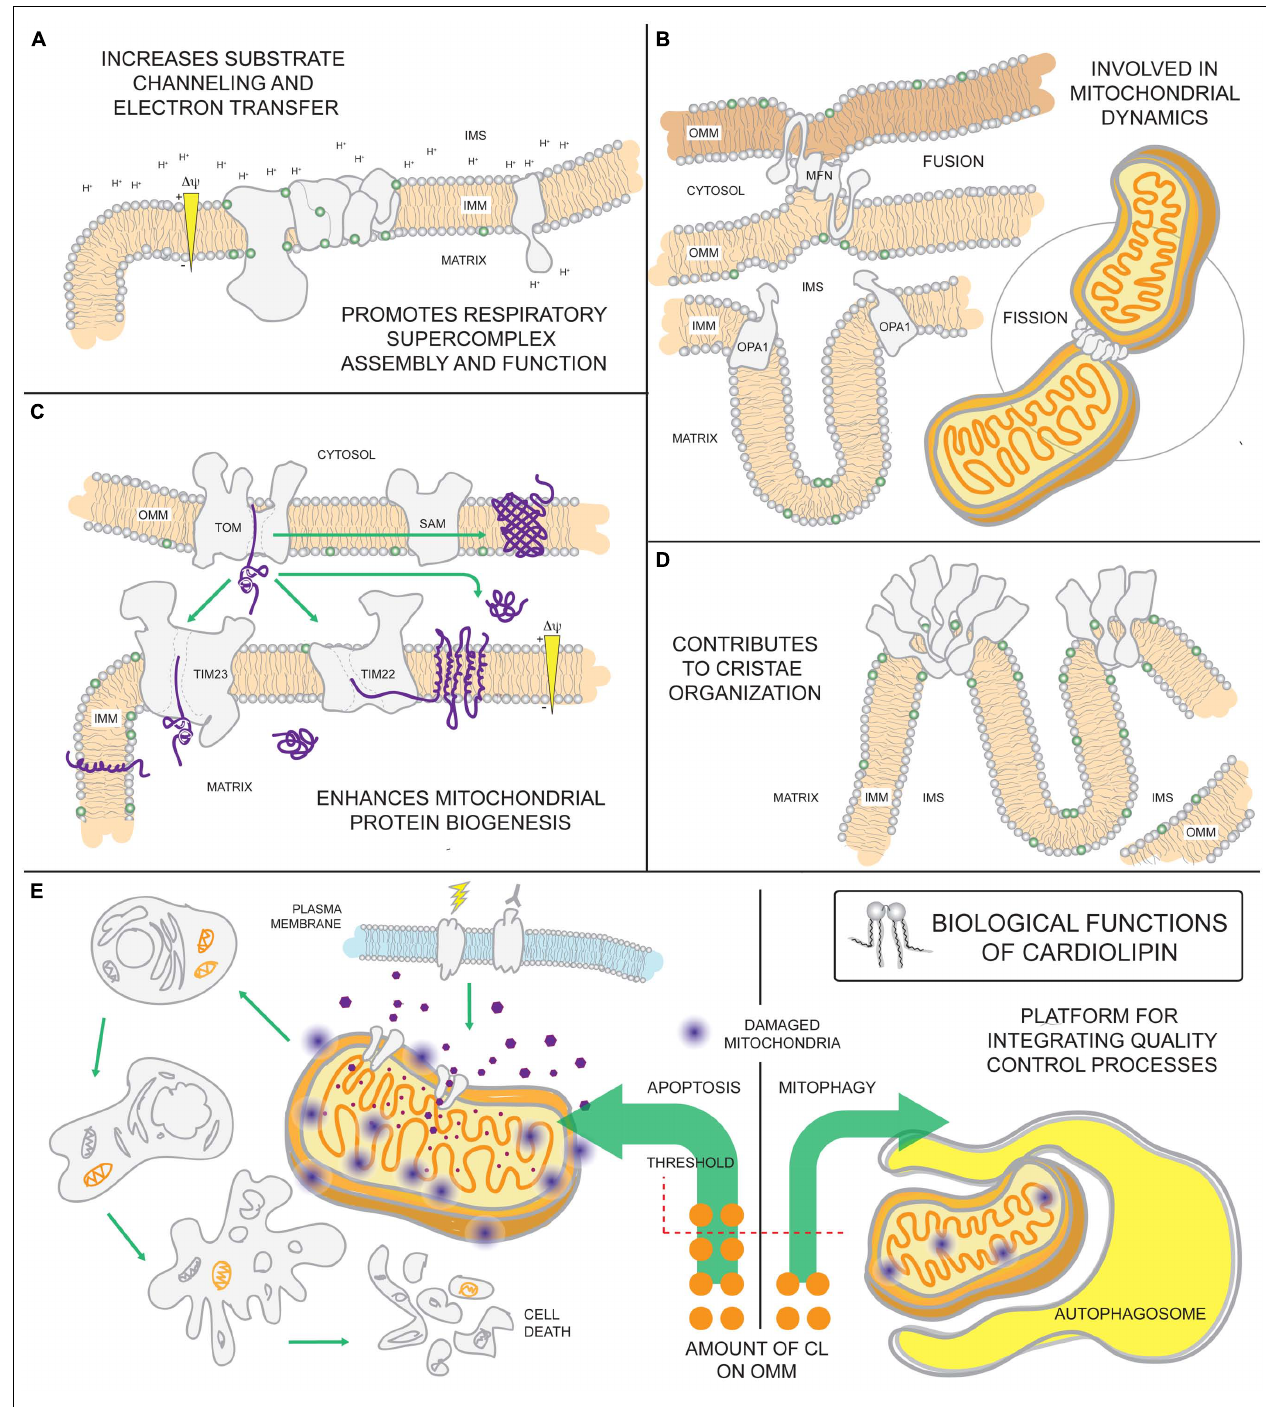
FIGURE 4 | Biological functions of cardiolipin. As the signature phospholipid of the mitochondrion, CL is intimately involved in a number of mitochondrial processes. (A) Anionic CL on the IMM can function as a proton trap by attracting (and providing) a local pool of protons that can be funneled towards the ATP synthase. Moreover, CL is associated with every OXPHOS component and can promote their assembly into respiratory supercomplexes. Such supramolecular assemblies are thought to enhance electron transfer and reduce ROS leakage from the electron transport chain. (B) CL associates